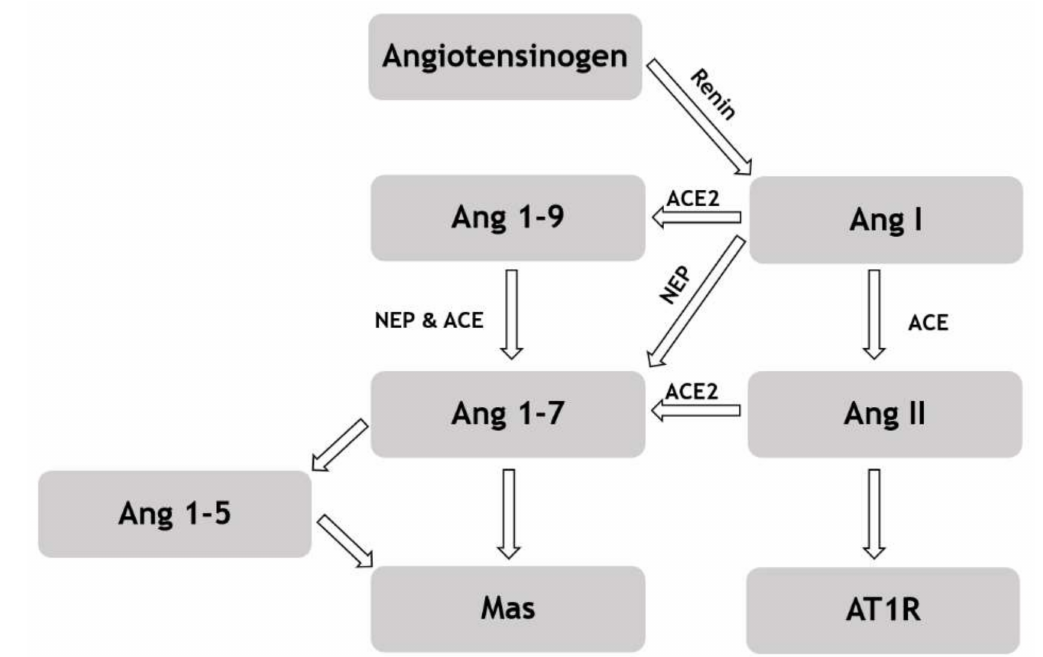
Figure 2. Scheme of the renin-angiotensin system pathways. Abbreviations: Ang—angiotensin, ACE—angiotensin converting enzyme, NEP—neutral endopeptidase—neprilysin, Mas—Mas receptor, AT1R—Angiotensin II type I receptor (modified according to